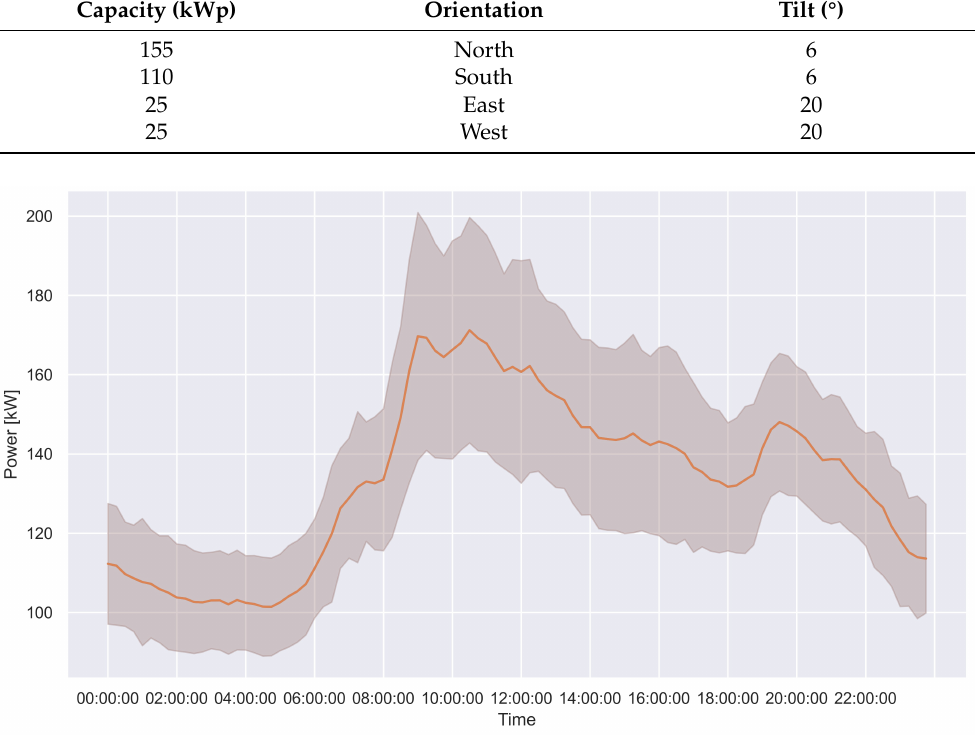
Figure 4. Average daily consumption profile and its standard